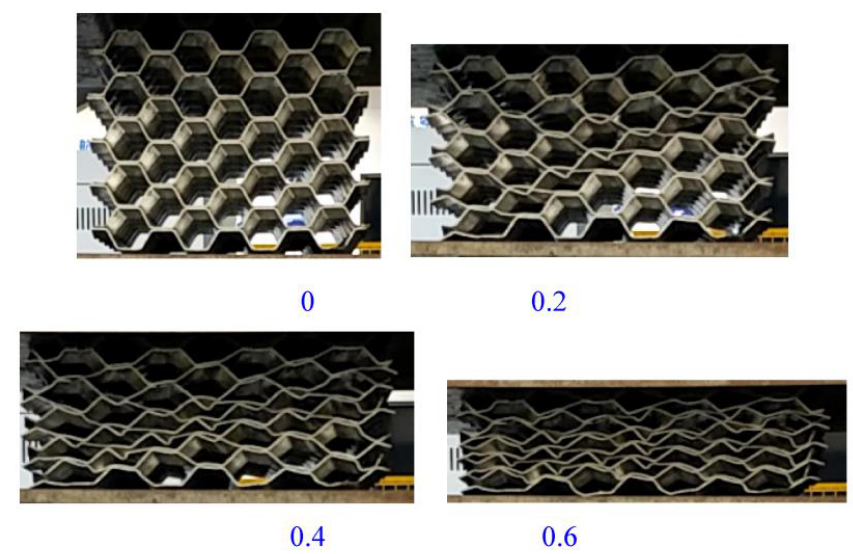
Figure 4. Pictures of the lateral compression process of origami honeycomb 1.